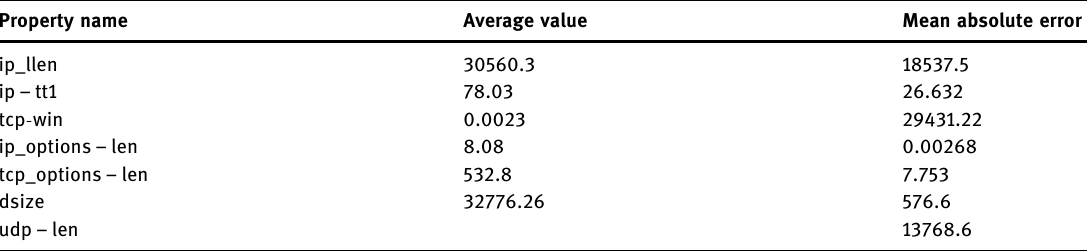
Table 4: Nample.txt data